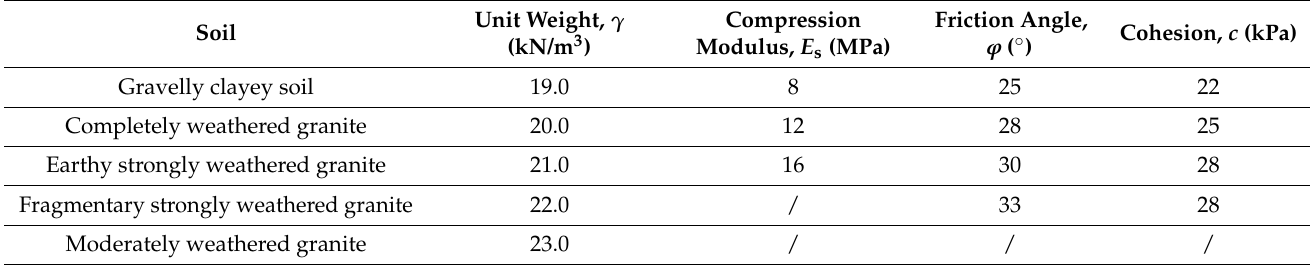
Table 1. The mechanical properties of soils.